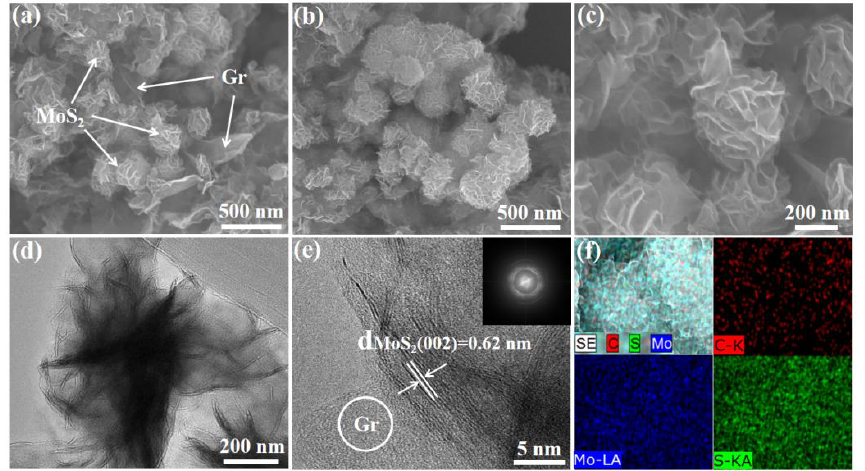
Figure 2. ( a , b ) Low-resolution and ( c ) high-resolution SEM images of the MoS 2 /Gr heterostructure. ( d ) TEM image of the MoS 2 /Gr heterostructure. ( e ) HRTEM image of the MoS 2 /Gr heterostructure (inset, the corresponding SAED image). ( f ) EDX mapping of C, Mo, and S.